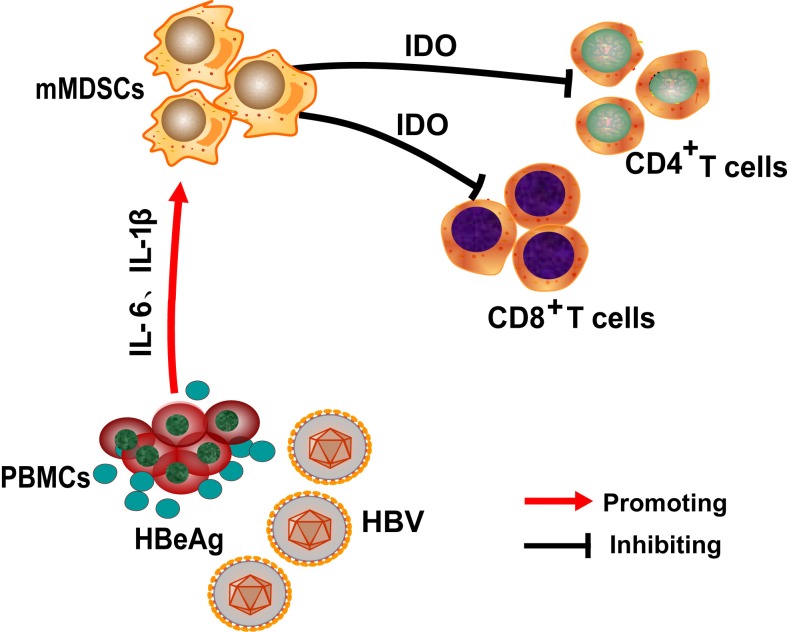
Mode of action of HBeAg-induced expansion of mMDSCs in CHB patients.The frequency of circulating mMDSCs is increased in CHB patients in the immune tolerant state. HBeAg induces the expansion of mMDSCs in an IL-6 and IL-1β dependent manner. HBeAg-induced upregulation of IDO expression in mMDSCs dampen T cell functions to promote HBV persistence.